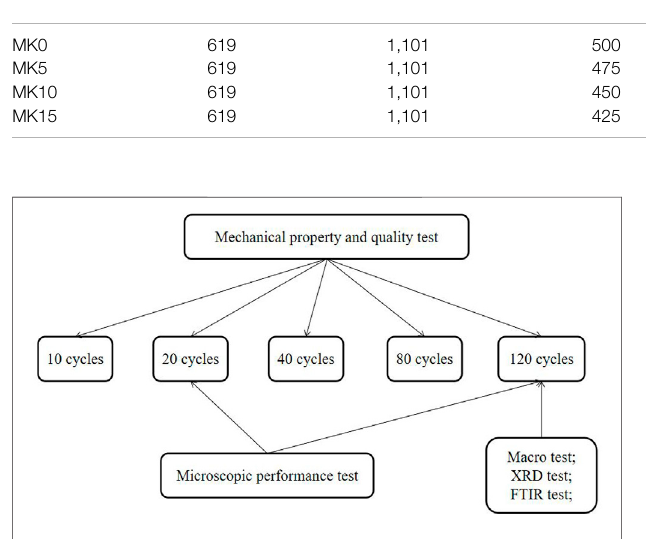
FIGURE 1 | Flow chart of the